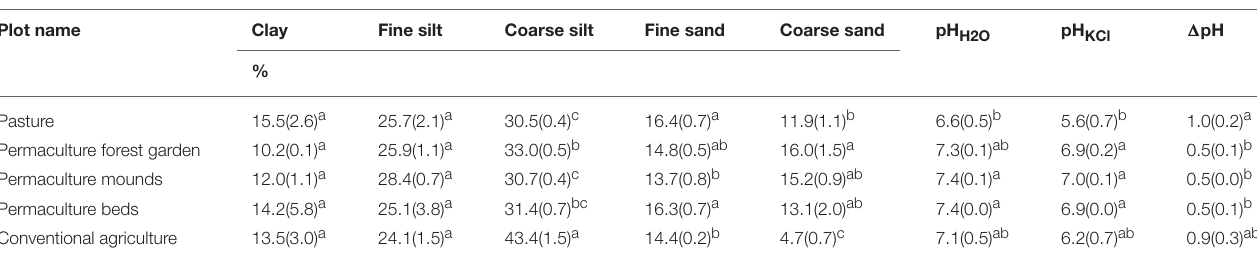
TABLE 4 | Soil particle-size distributions, pH (water and KCl) and difference between them ( 1